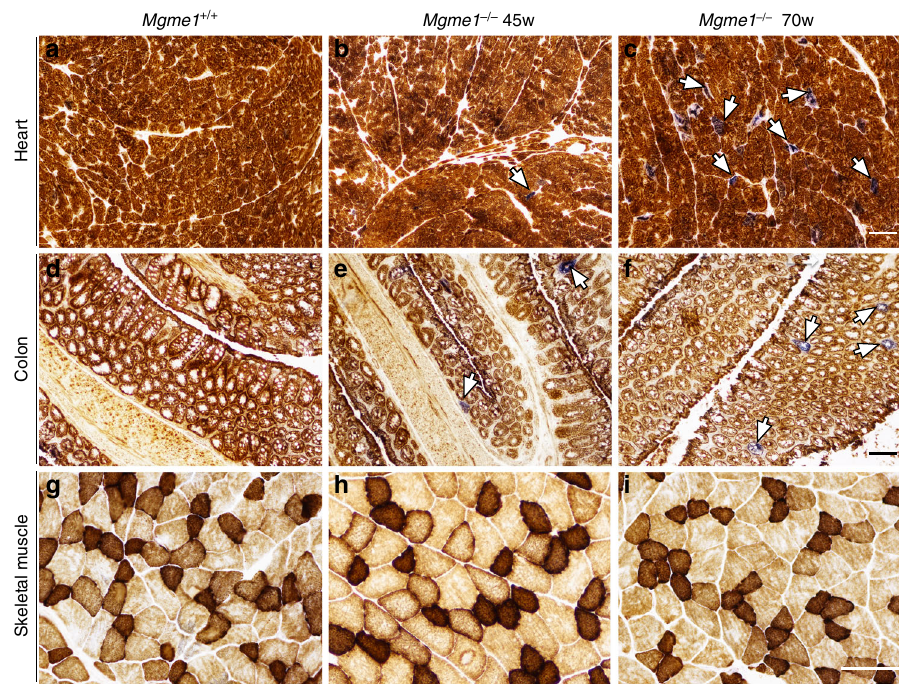
Fig. 4 Mgme1 − / − mice progressively accumulate COX negative cells in heart and colon tissue. COX/SDH staining of heart ( a – c ); colon ( d – f ); and skeletal muscle ( g – i ) from 45 and 70-week-old mice. White arrows indicate COX-defective cells. Scale bar, 100 µ m. Three biological replicates per